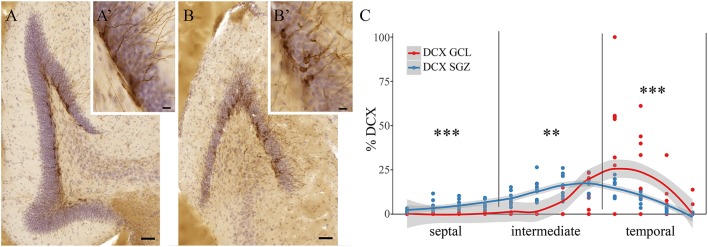
Radial location of DCX positive cells in bank voles and wood mice. DCX+ cells in wild rodents are not only found in the subgranular zone (SGZ, A,A'), but are found dispersed throughout the granular cell layer (GCL, B,B'). Quantitative assessment of DCX+ cells in the SGZ vs. those cells within the GCL reveals differences along the septo-temporal axis (C). While DCX+ cells in the SGZ predominate in the septal and intermediate hippocampus, significantly more DCX+ cells are found within the granule cell layer in the temporal subdivision. Scale bare (A,B) = 50 μm; (A',B') = 10 μm. **p < 0.01, and ***p < 0.001; for exact values see results.